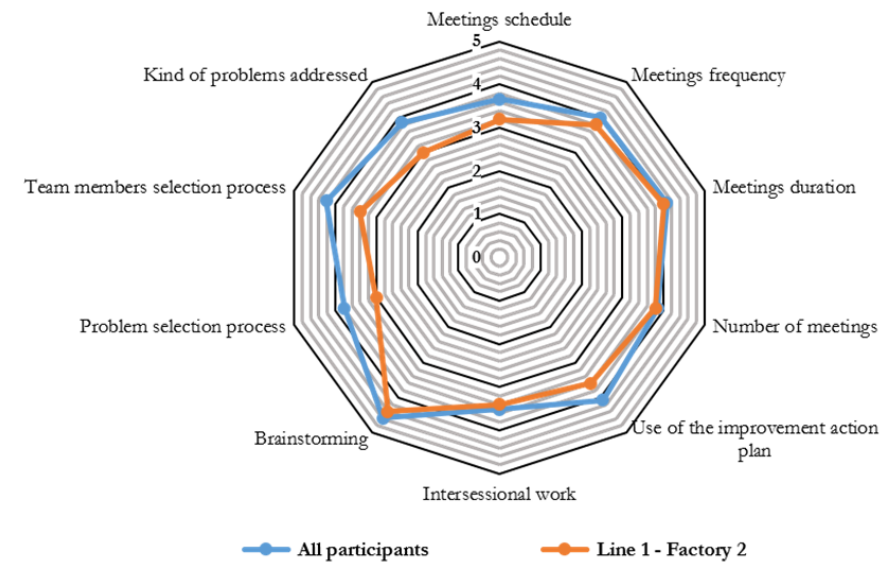
Figure 5. Methodological aspects assessment (All participants vs Line 1 – Factory 2)